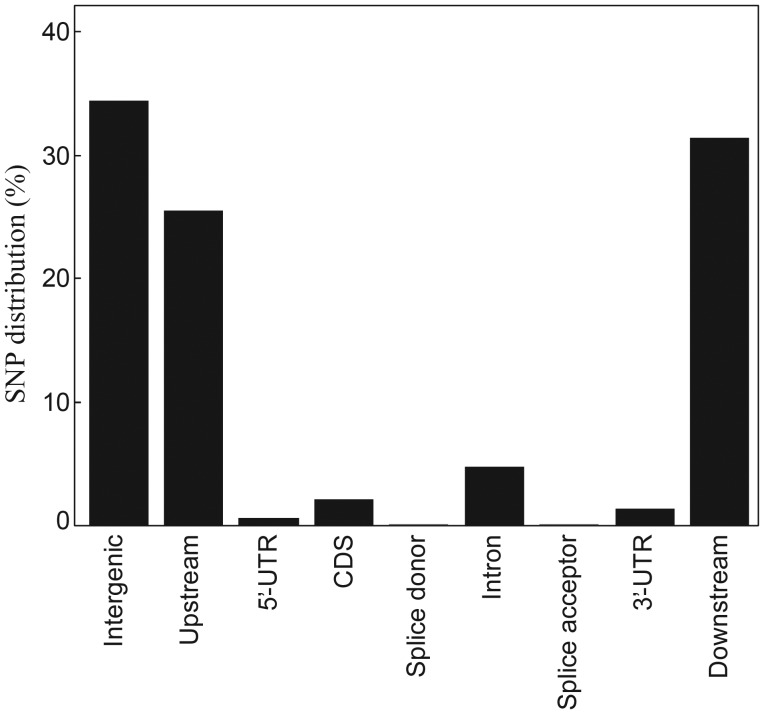
Distribution pattern of SNPs detected between the genomes of Nipponbare and Kasalath cultivars.